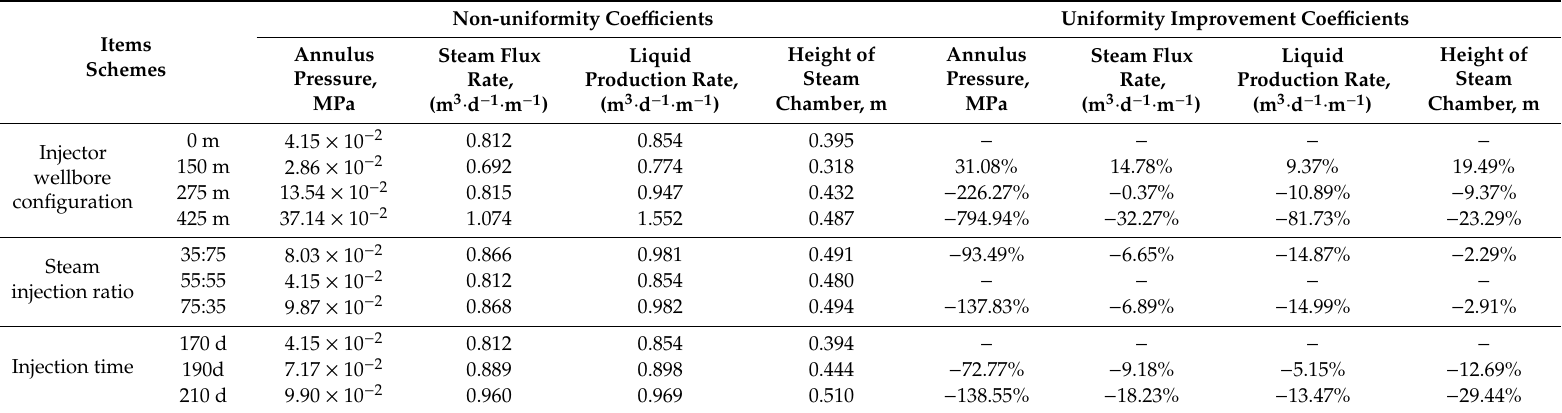
Table 3. Calculation results of the non-uniformity coe ffi cients and uniformity improvement coe ffi